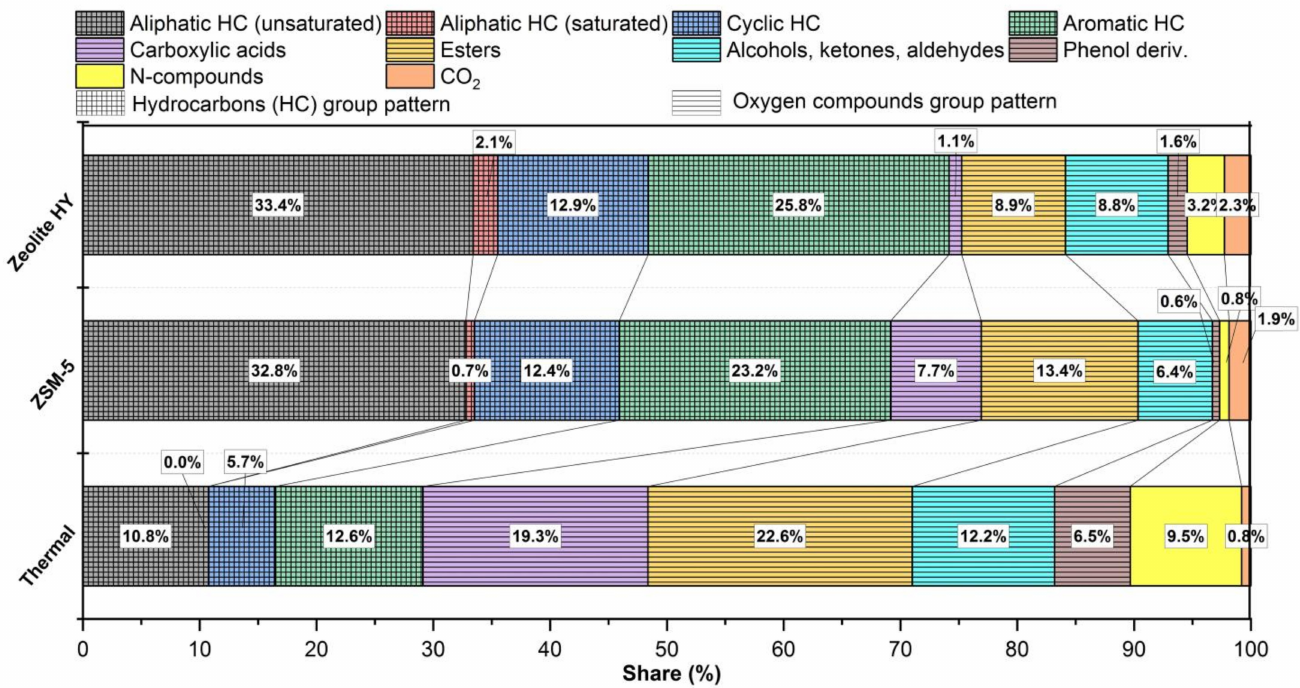
Figure 5. Comparison of group composition of the fractions evolved after thermal (500 ◦ C) and catalytic pyrolysis over ZSM-5 and HY zeolites (500 ◦ C) of the studied HTL